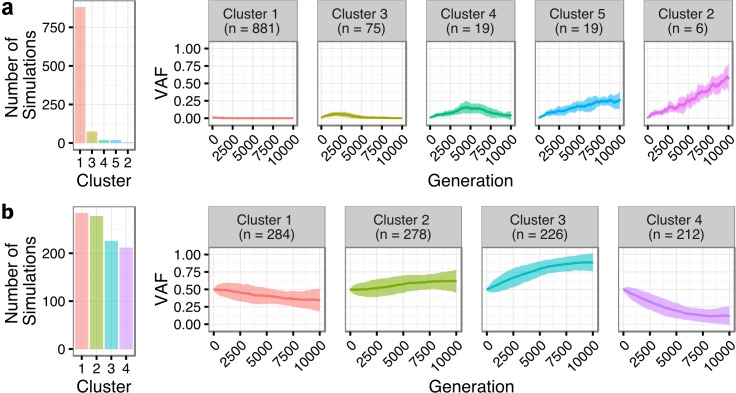
Tumor evolution modeling in transformed and progressed follicular lymphoma patients.Genetic drift modeling in TFL (A) and PFL (B) patients with an initial variant allele frequency of 1% and 50%, respectively. The far left bar plot indicates the number of simulations that follow a specific genetic drift trajectory (shown on the right). PFL, progressed follicular lymphoma; TFL, transformed follicular lymphoma; VAF, variant allele frequency.